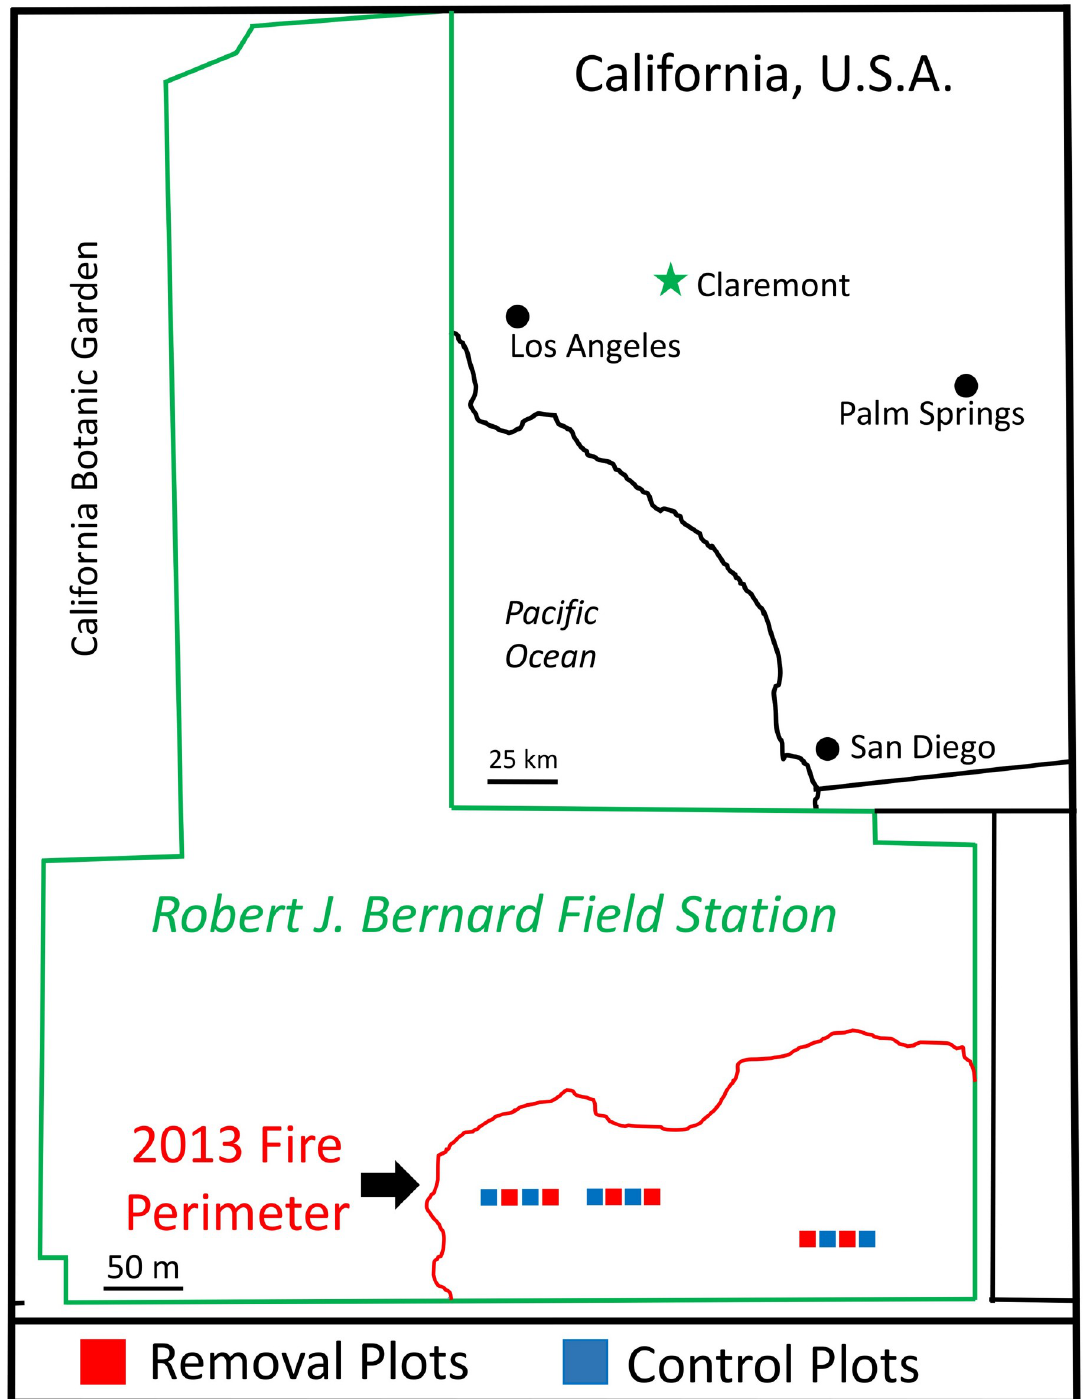
Fig 1. Map of the study area at the Robert J. Bernard Field Station in Claremont, CA. The filled squares represent the 12 study plots (100 m 2 each, red for non-native removal treatment and blue for control).